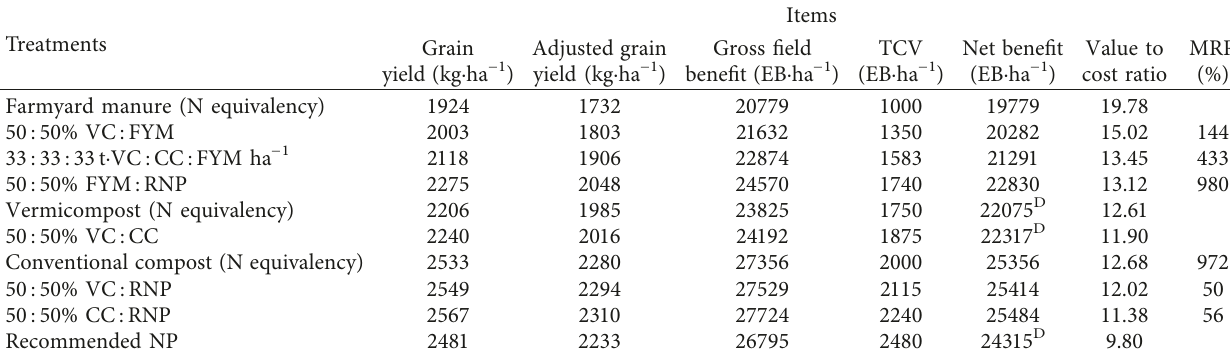
Table 4: Effects of the integrated use of organic and inorganic NP fertilizers on economic profitability of barley production on smallholder farmers’ fields in Chelia district. Treatments